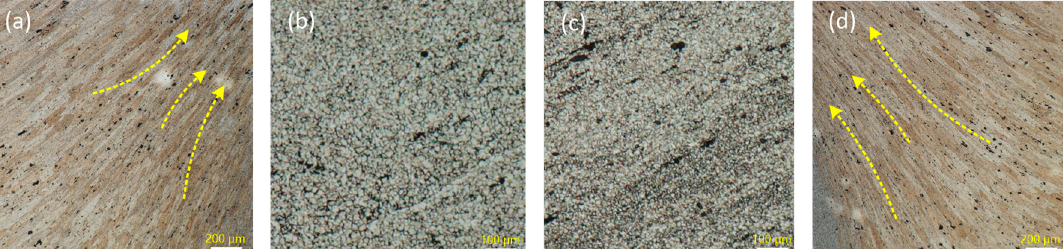
Figure 15. The microstructure of deformation zone of joint. ( a ) The microstructure on the advancing side; ( b ) shoulder stirring area (SSZ); ( c ) pin stirring area (PSZ); ( d ) the microstructure on the retreating side.